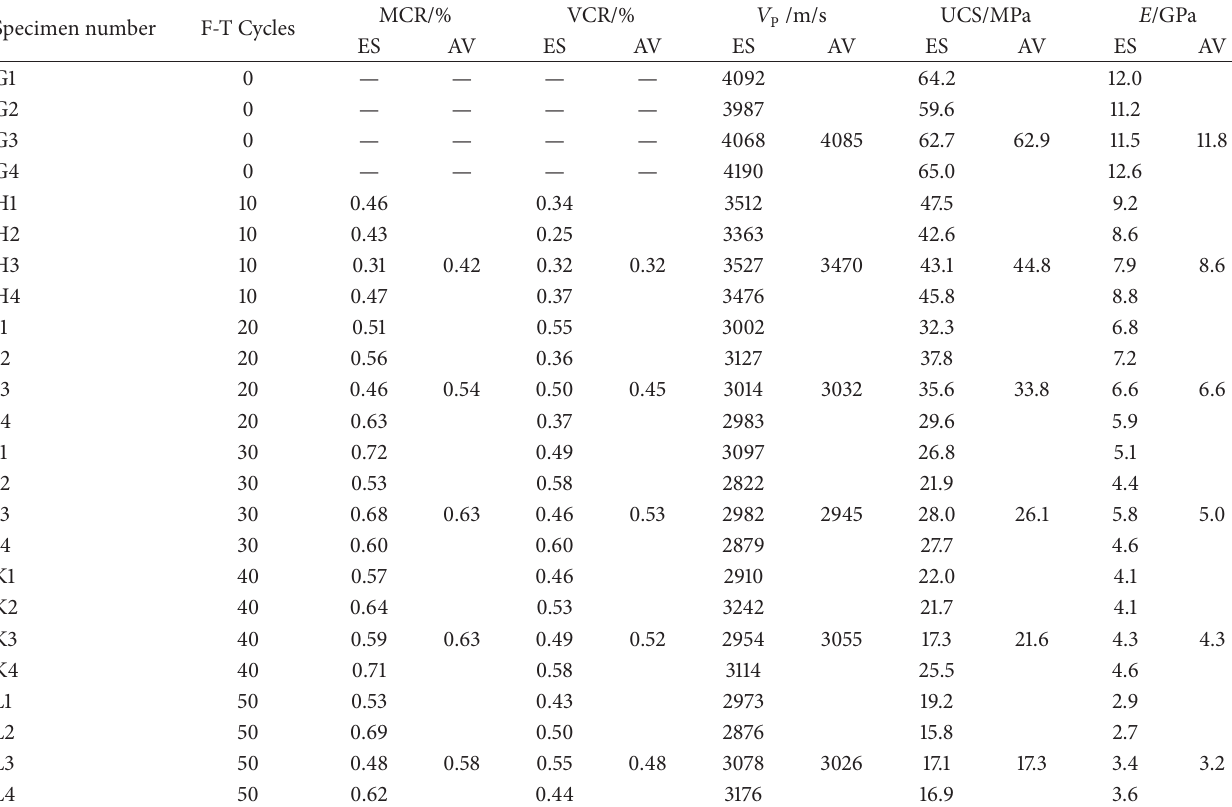
Table 2: Characteristics of damaged specimens after different numbers of F-T cycles.